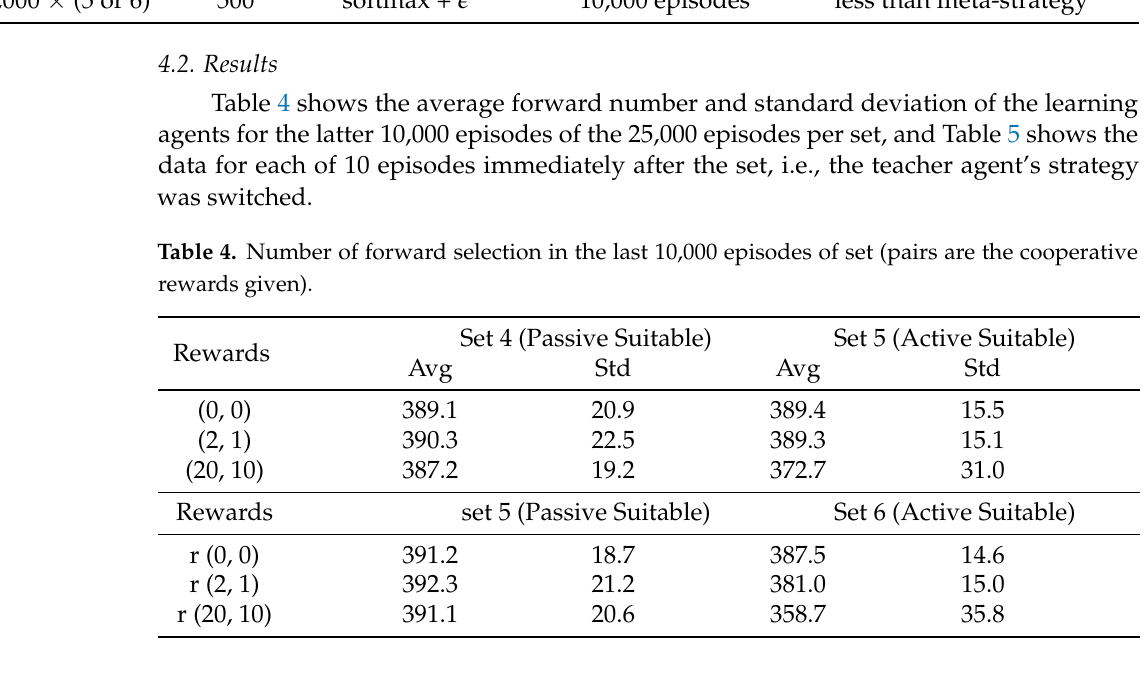
Table 5. Number of forward selection in the first 10 episodes after changing set (pairs are the cooperative rewards